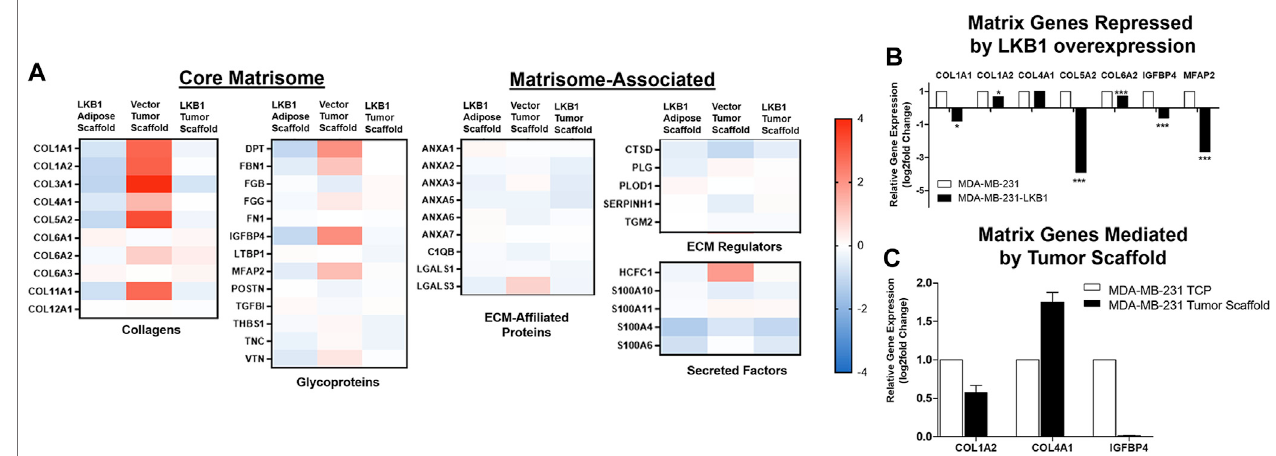
FIGURE 2 | LKB1 overexpression in MDA-MB-231 cells regulates breast tumor matrix remodeling. (A) MDA-MB-231 and -LKB1 cells were seeded on tumor and adipose scaffolds and implanted in the M.F.Ps of SCID/beige mice. At necropsy, tumors were removed, decellularized, and evaluated for differences in protein expression through proteomics. Normalization was to MDA-MB-231 cells seeded on the adipose scaffold. Results represent relative fold changes in protein expression forall detected matrixproteins. N =3mice pergroup forallgroups. Bluebands=decreased protein expression andred bands=increasedprotein expression. (B) Evaluation of previously published RNA sequencing of MDA-MB-231 and MDA-MB-LKB1 (Rhodes et al., 2015) cell lines grown in 2D with a focus on ECM interactions. Resultsrepresentfoldchangesinrelativegeneexpressionchangesobservedinmatrix-associatedgenesintheMDA-MB-LKB1overexpressingcellline.* p < 0.05,*** p < 0.001. (C) MDA-MB-231 parental cells were seeded on tumor scaffolds for 24 h and then evaluated ex vivo via qRT-PCR for matrix-associated genes (COL1A2, COL4A1, and IGFBP4). Normalization was to MDA-MB-231 cells seeded on tissue culture plastic (TCP), housekeeping gene was GAPDH, and error bars represent SEM, n =